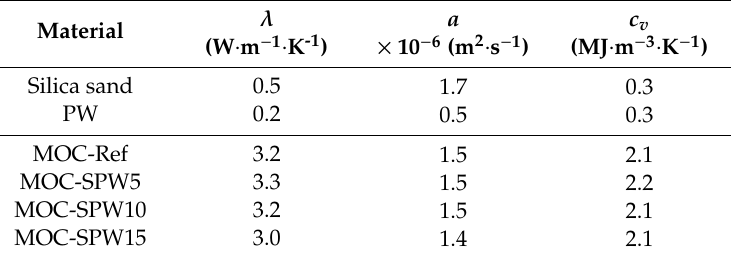
Table 8. Thermal characteristics of MOC composites.